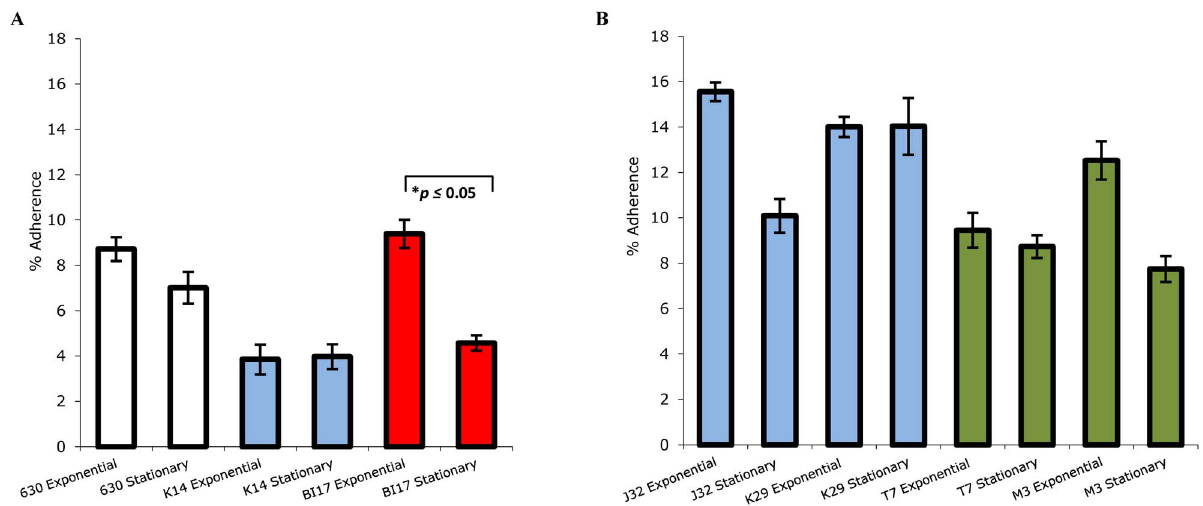
Figure 3. Adherence of C.difficile strains to host cells varies with growth. Bacterial strains grown to early stationary phases or exponential phases of growth were evaluated for adherence to epithelial cells. Percentage adherence with standard errors of the mean are depicted. Panels A and B represent two independent sets of strains examined. For strains in Panel A, the assays were performed in triplicate, and repeated in entirety at least twice, while those in Panel B were assayed once in quadruplicate. Strains 630 and VPI10463 are indicated as clear bars, the ribotype 001 strains as blue bars, epidemic-associated, ribotype 027 strains as red bars, and non-toxigenic strains as green bars.